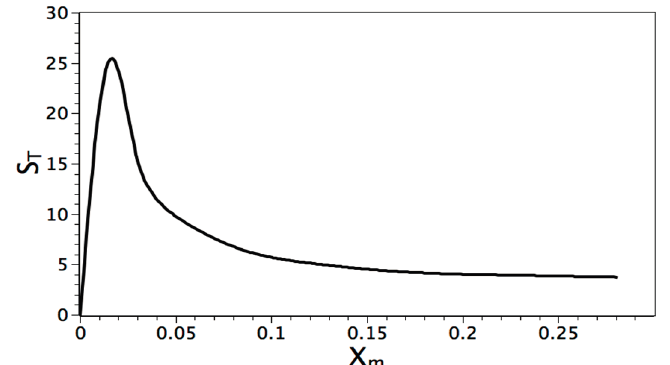
X during latent heat transfer with Pr 50 = and Ra = 10 5 m